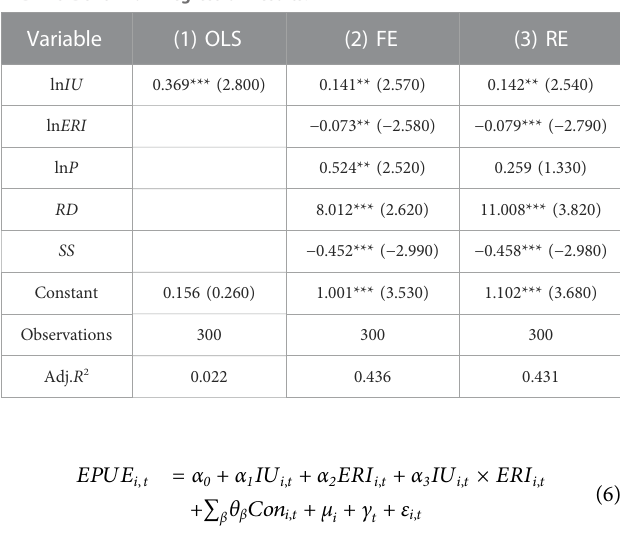
TABLE 3 Benchmark regression results. TABLE 4 The moderation effect of environmental regulation